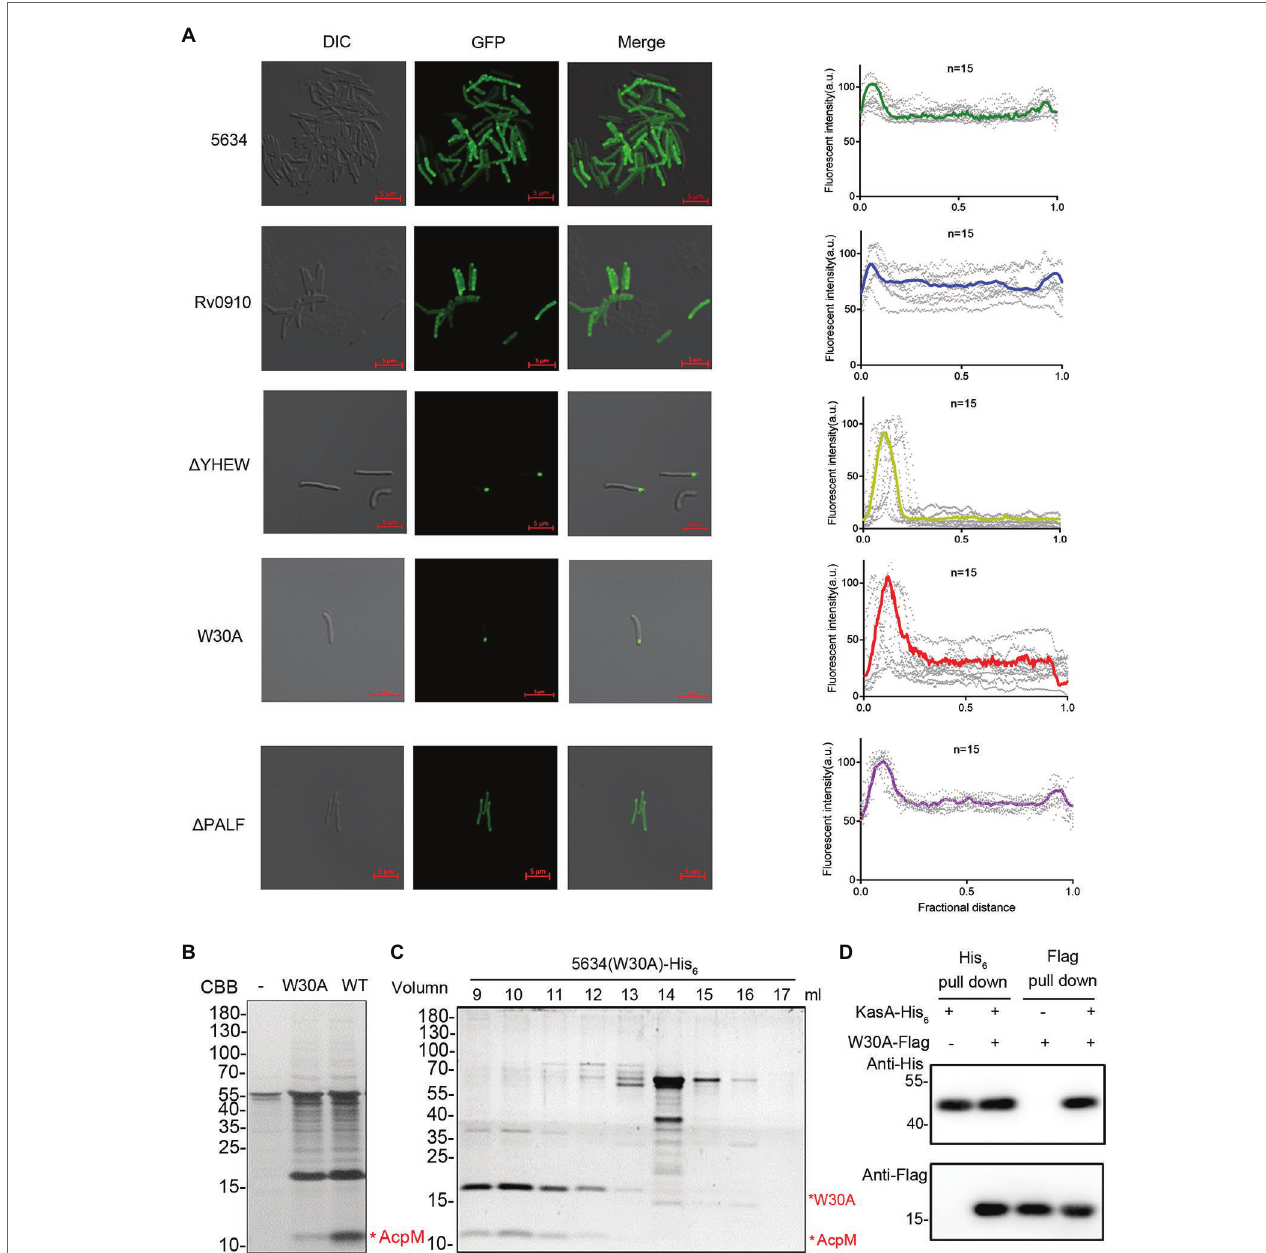
FIGURE 5 | Cellular locations of MSMEG_5634, its mutants, and its homologous protein. (A) MSMEG_5634, its homologous protein Rv0910, and MSMEG_5634 Δ PALF (113–116 residues of the α 3 helix), Δ YHEW (27–30 residues of the α 2 helix), and W30A mutants were expressed with GFP fused at the C-terminus in Mycobacterium smegmatis . The cellular locations of these GFP fusion proteins were detected by confocal microscopy. The fluorescence quantification over the long axis of cells was performed and analyzed by ImageJ profile. (B) MSMEG_5634-His 6 and MSMEG_5634 (W30A)-His 6 were expressed in M. smegmatis and purified by Ni 2+ -NTA affinity chromatography, respectively. The eluted proteins were collected and analyzed by Tricine-SDS-PAGE. (C) The total protein sample copurified with MSMEG_5634 (W30A)-His 6 expressed in M. smegmatis was subjected to size exclusion chromatography. The resulting fractions were collected every 1 ml and then analyzed by Tricine-SDS-PAGE. (D) The interaction between MSMEG_5634 (W30A) and KasA was detected by pull-down assays. Flag-tagged MSMEG_5634 (W30A) was coexpressed with His 6 -tagged KasA in E. coli . Flag-tagged MSMEG_5634 (W30A) was purified by Flag affinity chromatography, and His 6 -tagged KasA was purified by Ni 2+ -NTA affinity chromatography, respectively. The eluted proteins were analyzed by SDS-PAGE and Western